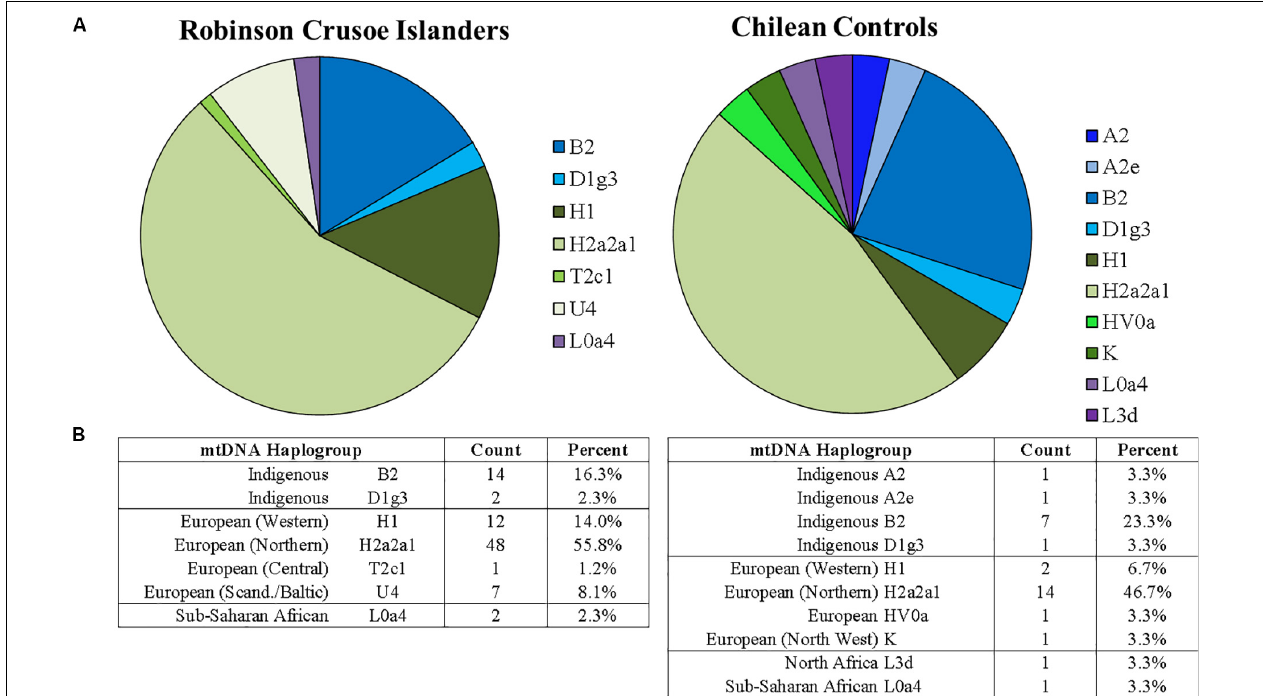
FIGURE 1 | (A) Proportions of mitochondrial haplogroups found on Robinson Crusoe Island ( N = 86) (left) compared to Chilean controls (from Santiago) ( N = 30) (right). Haplogroup origins are grouped by color: those common to South American indigenous populations (blue), Northern Europe (green) and Africa (purple). (B) Counts of mitochondrial haplotypes found in Robinson Crusoe Island and mainland Chilean controls grouped by Indigenous and European